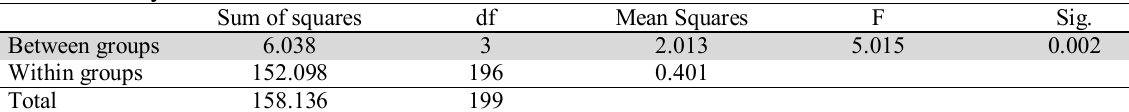
The summary of ANOVA test Sum of squares df Mean Squares F Sig. Between groups 6.038 3 2.013 Within